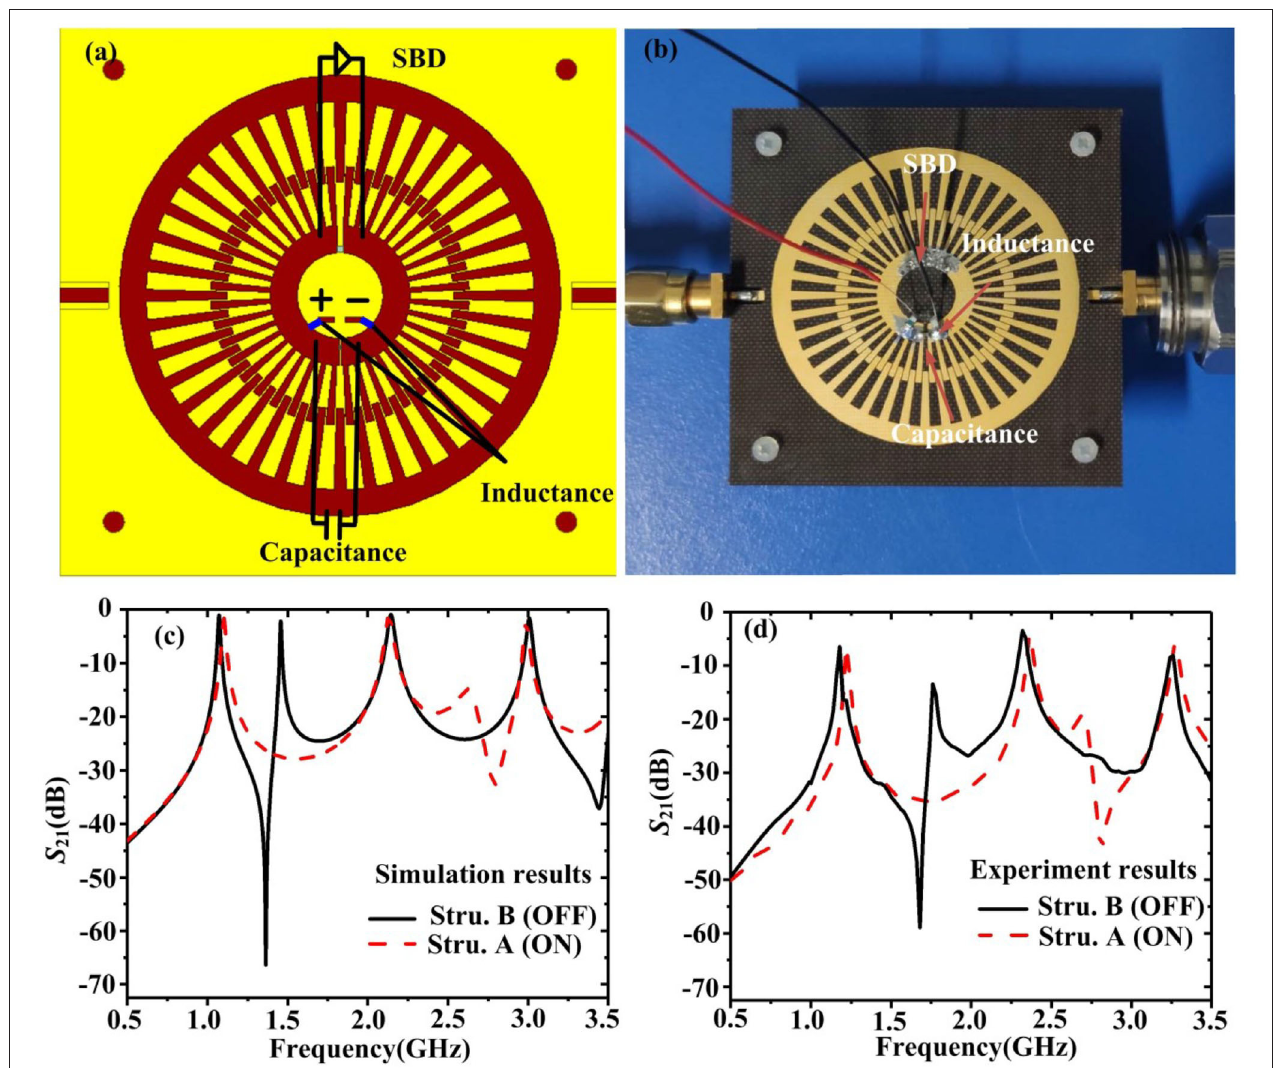
FIGURE 5 | (a) Schematic of the active two-way Fano resonance switch. (b) Fabricated sample. (c) Simulated and (d) measured transmission coefficients S 21 of the active two-way Fano resonance